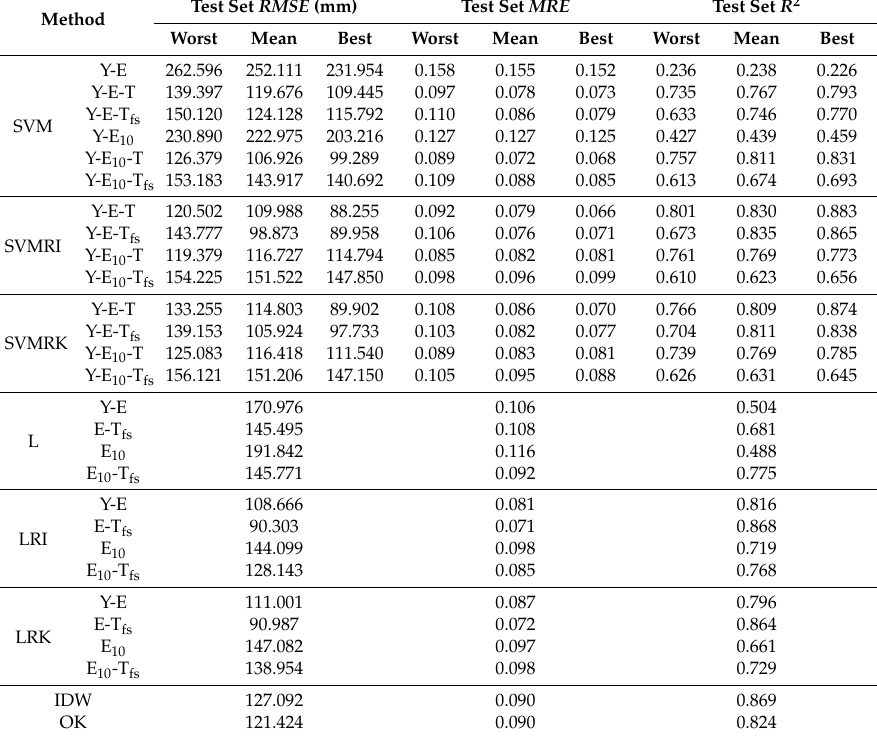
Table 3. Test station error indicators. SVMRI, SVM residual inverse distance weighting; SVMRK, SVM residual kriging; LRI, linear regression residual inverse distance weighting; LRK, linear regression residual